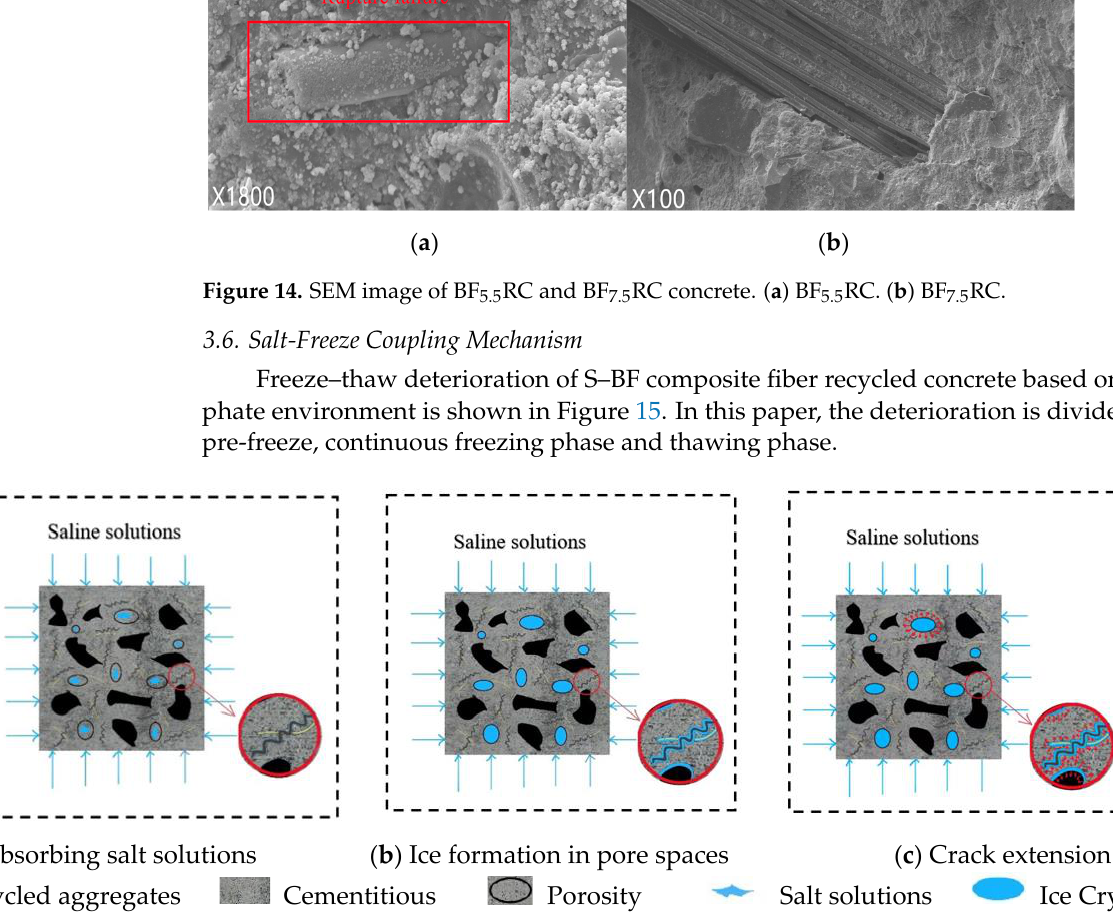
Figure 15. Deterioration phenomenon with S – BF recycled